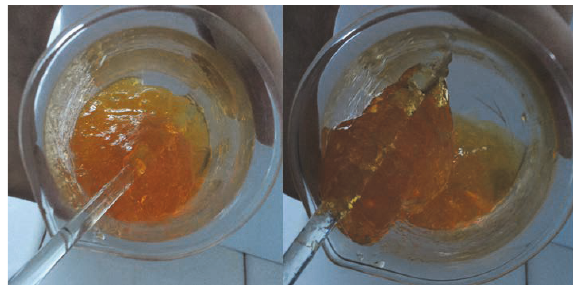
Figure 10: Cross-linking of guar with 400 ppm FeCl 2 (Sample TI-5).